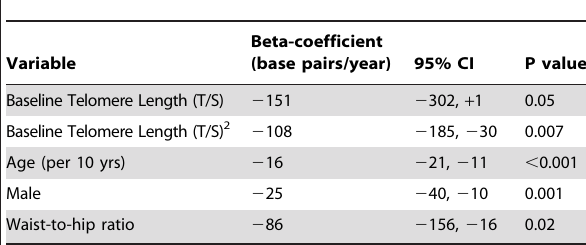
Table 2. Independent predictors of change in leukocyte telomere length as a continuous variable (multivariable linear regression with backward selection of candidates in table 1 retained at p , 0.1).